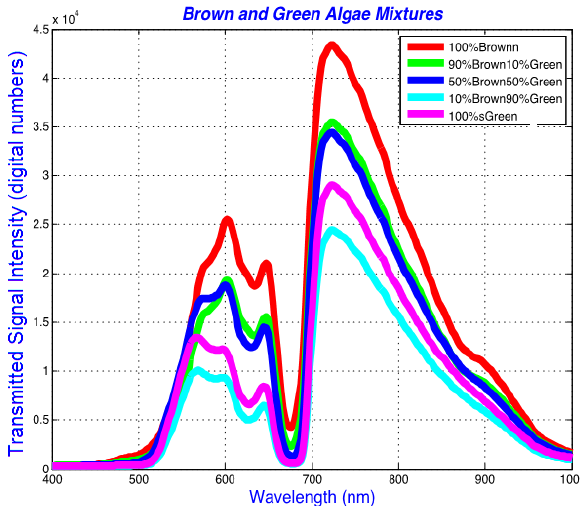
Figure 5. Sample average spectra showing spectral response from 100% brown algae (diatom: Cyclotella sp.), 100% green algae, and various volumetric mixtures between the two species. The samples represent densely grown algae, capturing absorption peaks of its key components, such as chlorophyll.